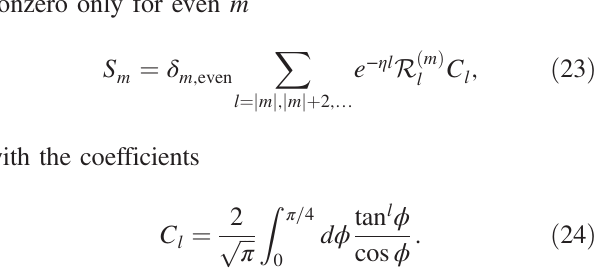
with increasing j m j [52].